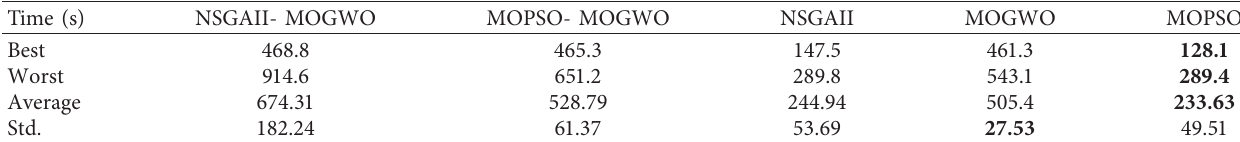
Table 15: Computing time for five algorithms in ten independent runs.